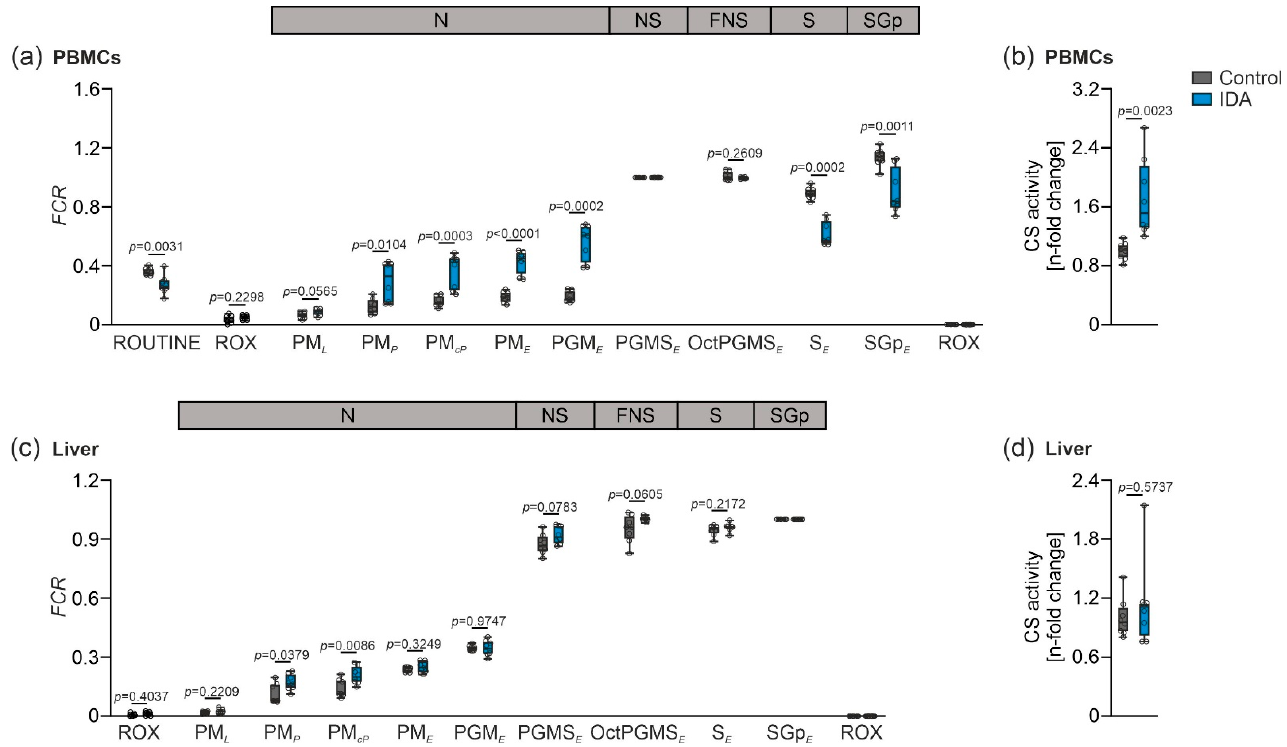
Figure 3. Mitochondrial respiration in PBMCs and liver from control and IDA rats independent of mitochondrial density and citrate synthase (CS) activity. ( a ) FCR calculated from PBMC respiration with reference state PGMS E . States: ROUTINE: living cells; ROX: digitonin; PM L : PM; PM P : ADP;